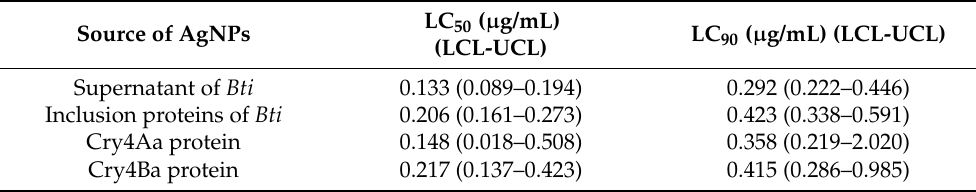
Table 2. Mosquitocidal activity of Ag/AgCl NPs synthesized using supernatant and solubilized inclusion proteins of Bti against A. aegypti